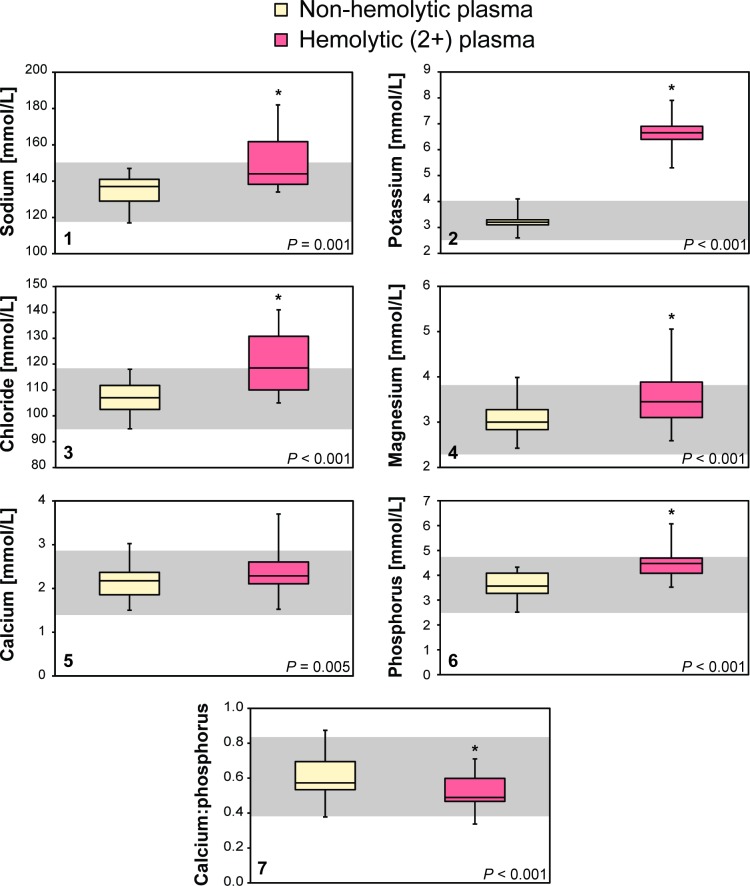
Comparison of electrolytes (1: sodium; 2: potassium; 3: chloride) and minerals (4: magnesium; 5: calcium; 6: phosphorus) in non-hemolytic and hemolytic plasma from leatherback sea turtles (Dermochelys coriacea).The line represents the median, the boxes represent the first and third quartiles, while the whiskers represent the range. * indicates a significant difference between the two samples as determined by a paired-samples t-test (P < 0.0033). Data is presented in SI units.